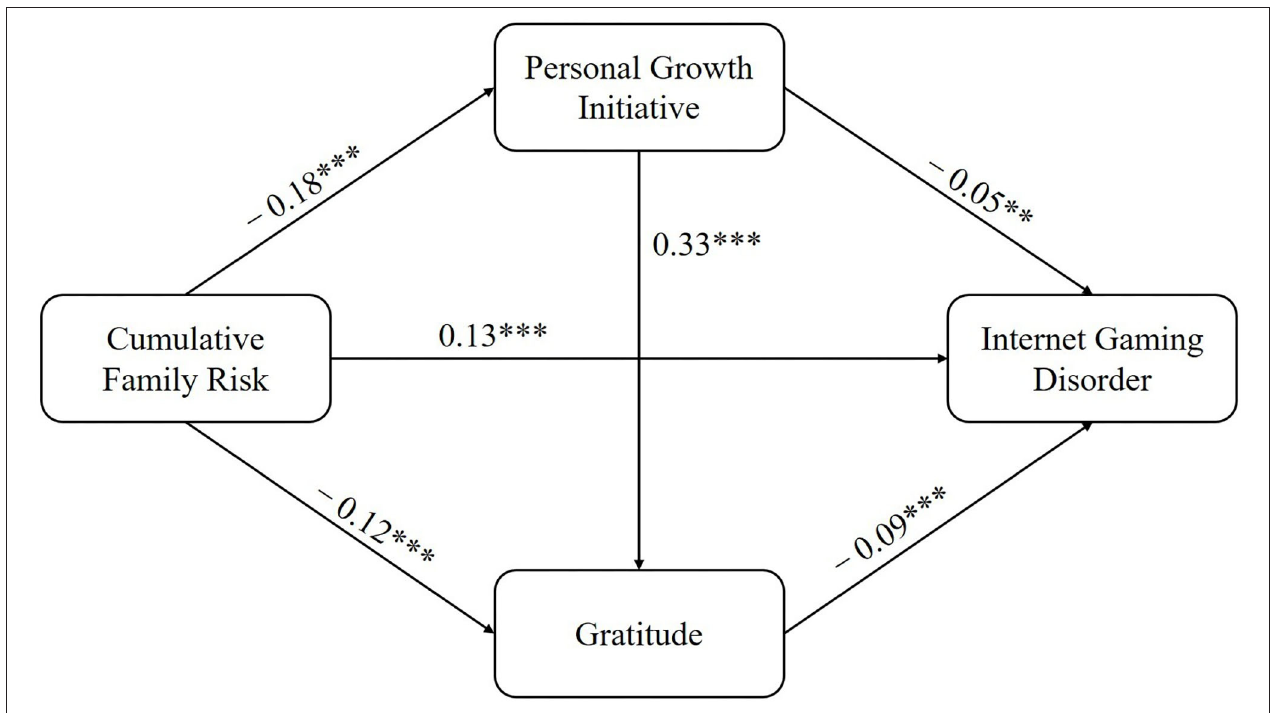
FIGURE 2 | The multiple mediation model between cumulative family risk and IGD. ** p < 0.01, *** p < 0.001.